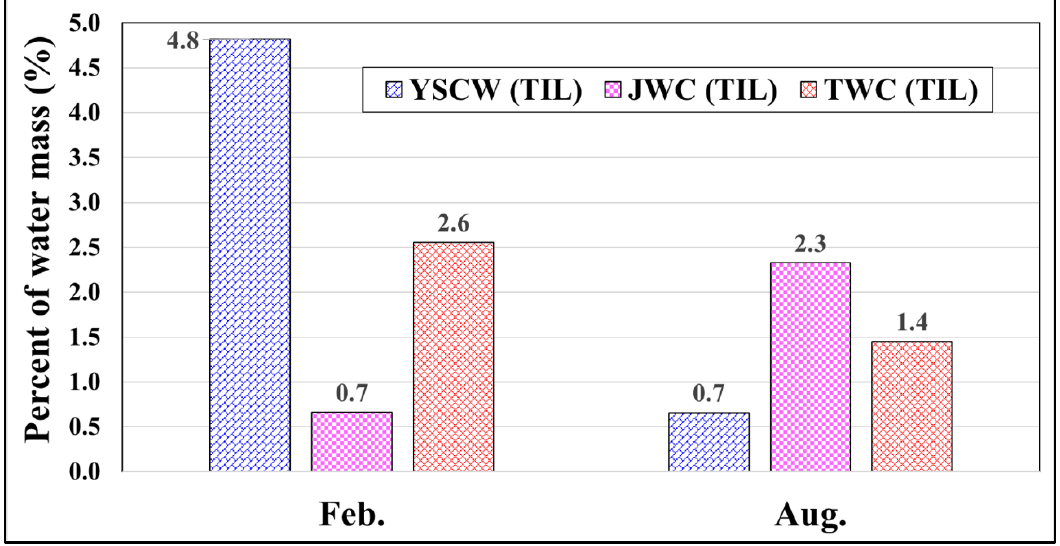
Figure 5. Percent of water mass of Yellow Sea Cold Water (YSCW), Jeju Warm Current (JWC), and Tsushima Warm Current (TWC) in water temperature inversion layer in February and August from 1995 to 2016.